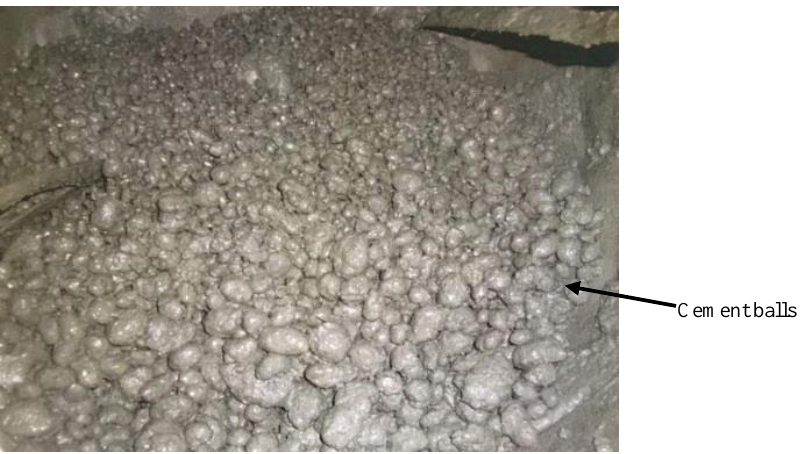
Figure 1. Formation of cement balls during the mixing process.